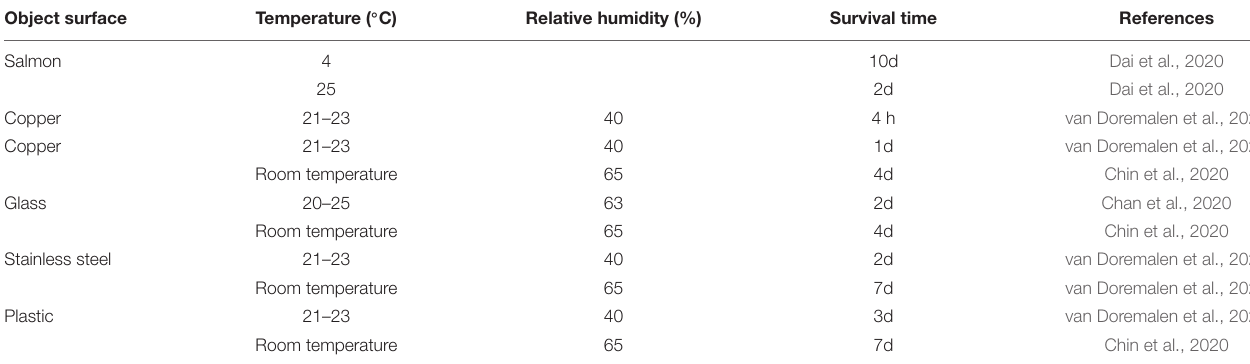
TABLE 1 | Survival time of SARS-COV-2 on different surfaces. Object